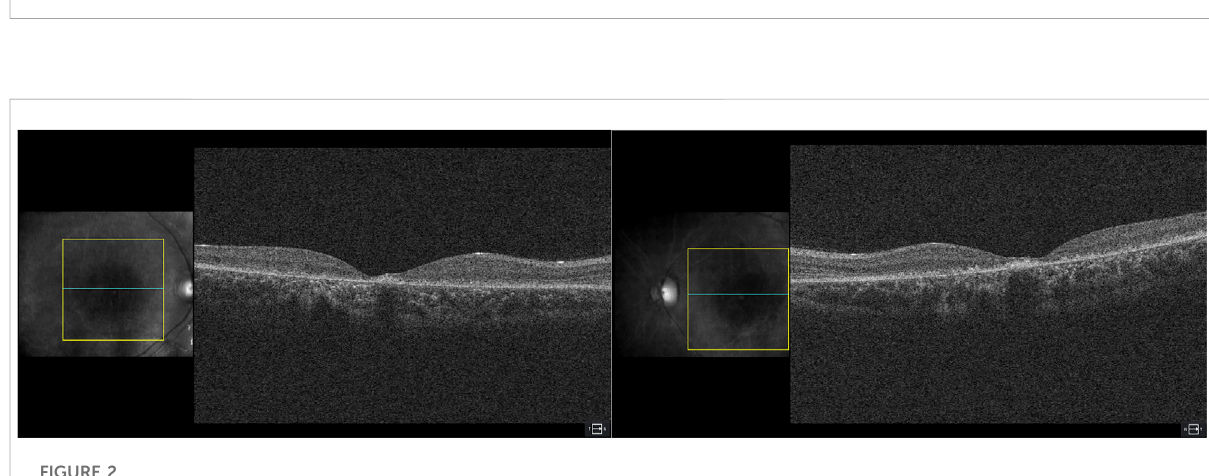
FIGURE 2 High-resolution spectral domain optical coherence tomography (SD-OCT) demonstrated decreased retinal thickness, particularly at the foveola, with loss of inner and outer photoreceptor segment layers and hyper-re fl ective deposits below the RPE corresponding to fl